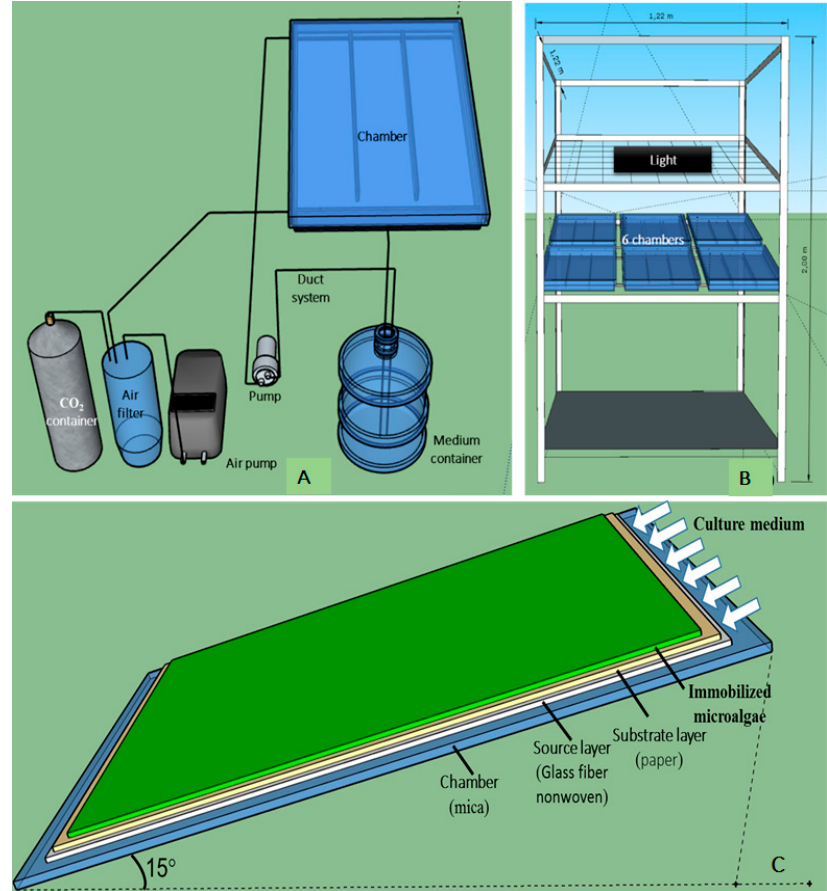
Figure 1. The small-scale angled TL-PSBR: nutrient and air supply system for cultivation chamber ( A ), positioning of chambers and lights ( B ), components inside a chamber ( C ).